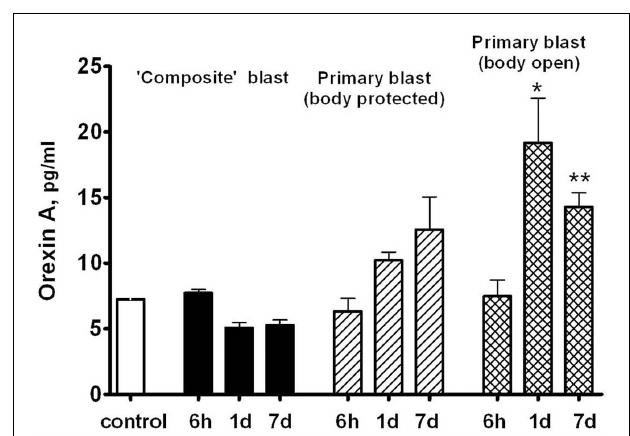
FIGURE 8 | Soluble intercellular adhesion molecule -1 (A) and L-selectin (B) concentrations in rat serum following blast exposure. Blood was collected after blast at different shock tube set-ups and assayed by SW ELISA. Unpaired t- test was done to